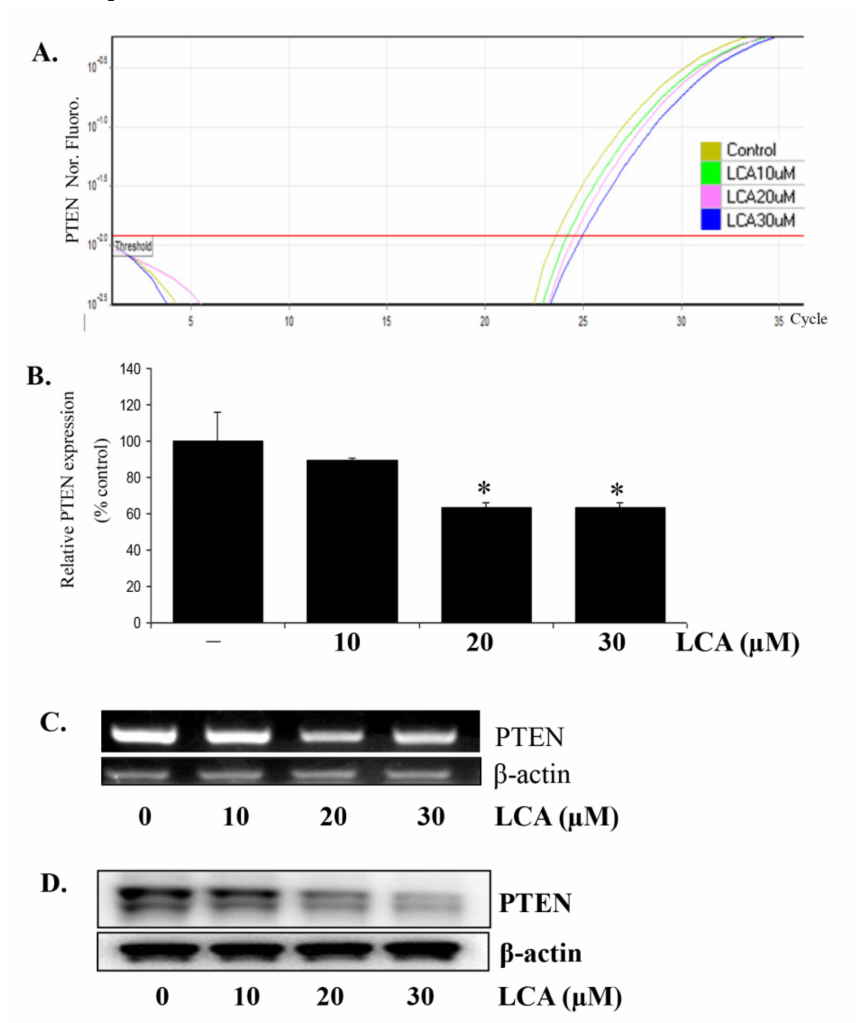
Figure 5. LCA inhibits PTEN expression in HCT116 cells. HCT116 cells were treated with LCA at 10 µ M–30 µ M concentration for 24 h. The cells were then extracted for total RNA and total protein for checking PTEN expression by Realtime-PCR ( A , B ), RT-PCR ( C ), and Western blot ( D ). * p < 0.05 versus control. The above data represent the means ± SD from triplicate